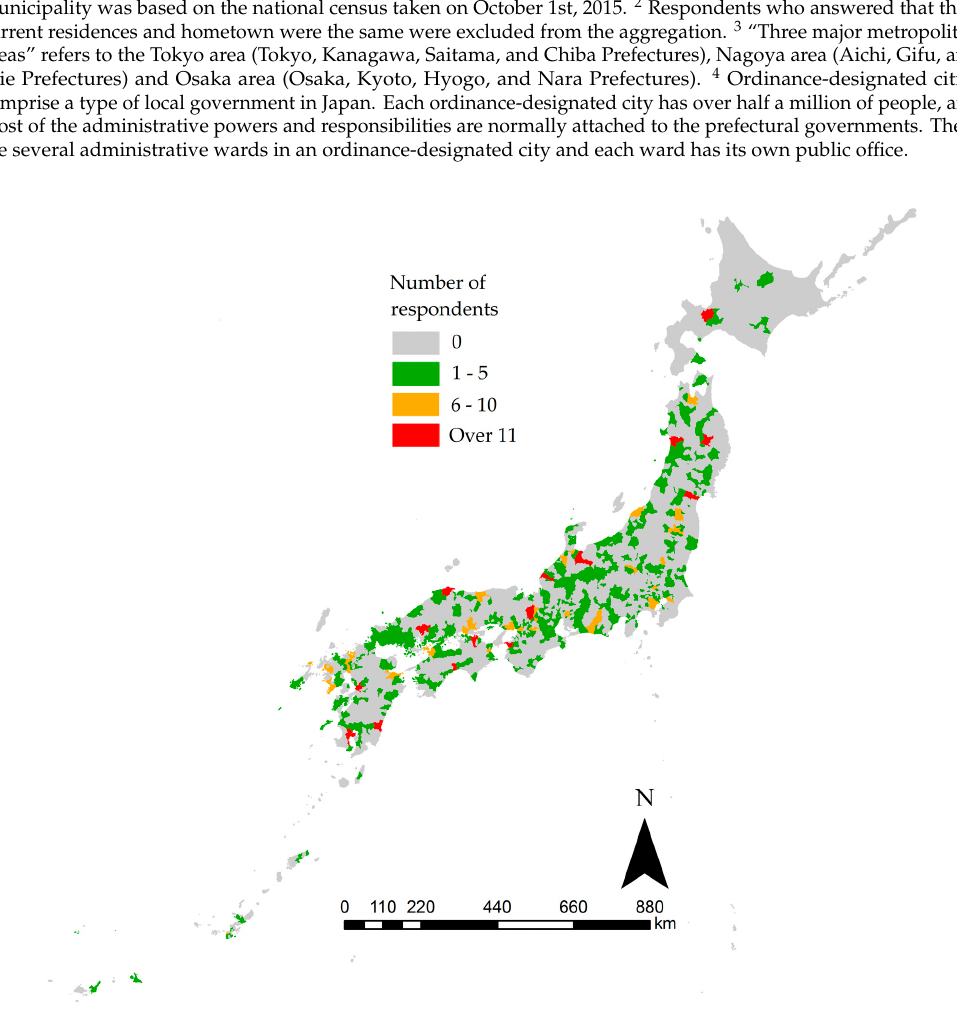
Figure 1. The spatial distribution of respondents’ current residences by municipal